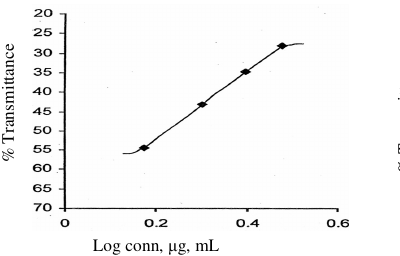
Figure 9. Ringbom plot of REB- SAc-HNO